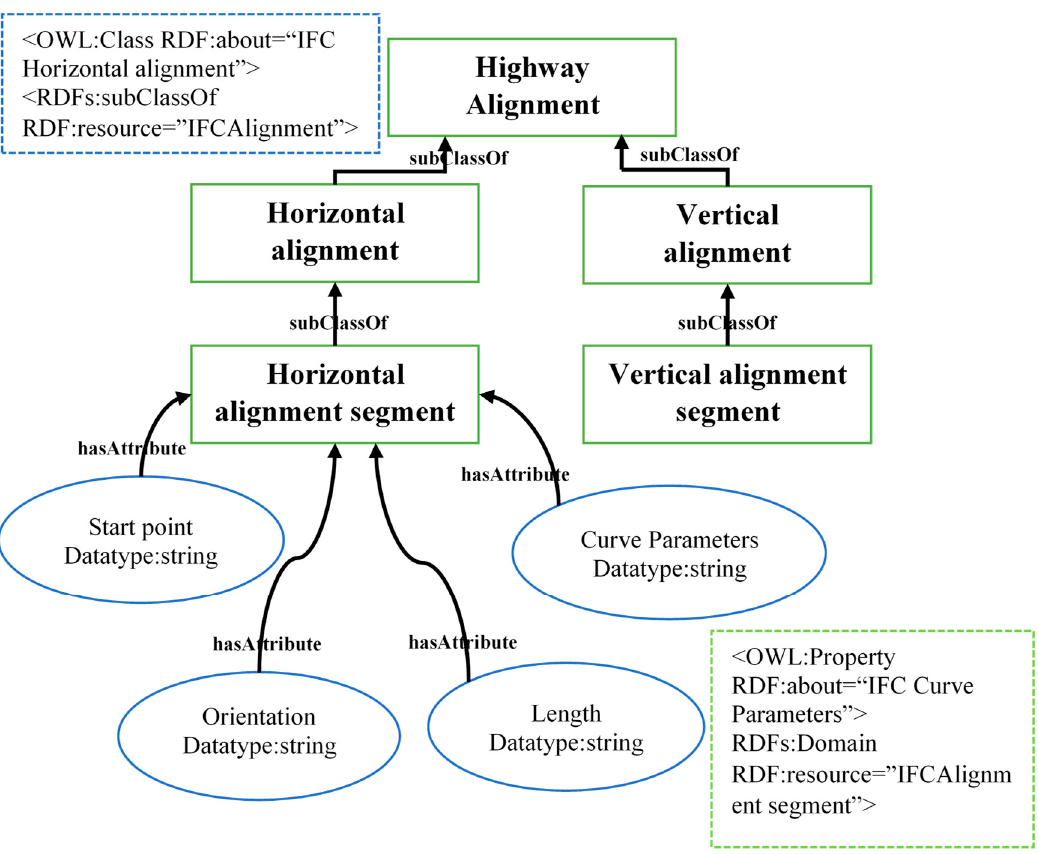
Figure 2. A building information modelling (BIM) entity representation as an resource description framework (RDF) graph and web ontology language (OWL) Classes.